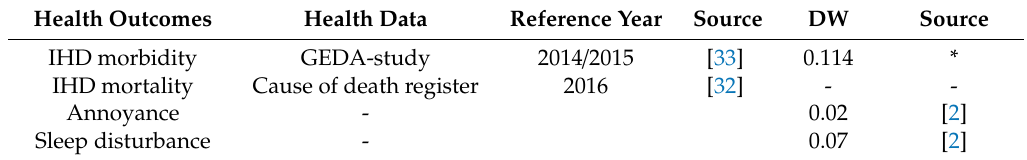
Table 4. Input data used for the calculation of the burden due to tra ffi c noise exposure in Germany. Health